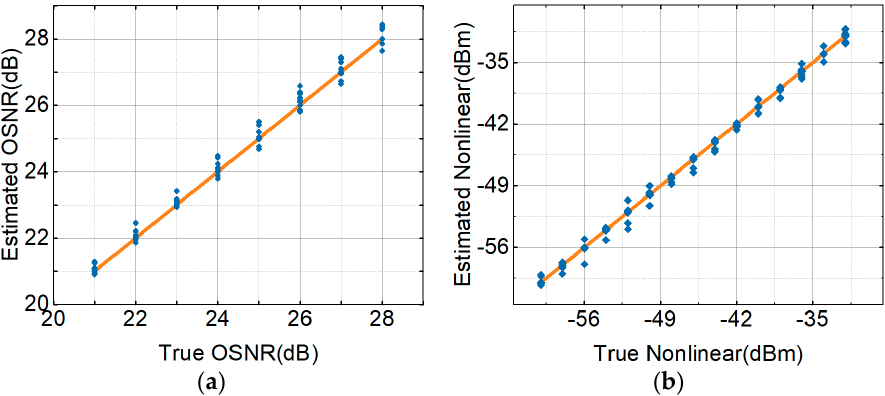
Figure 11. Monitoring error for all signals, ( a ) OSNR estimation, ( b ) NL noise power estimation.